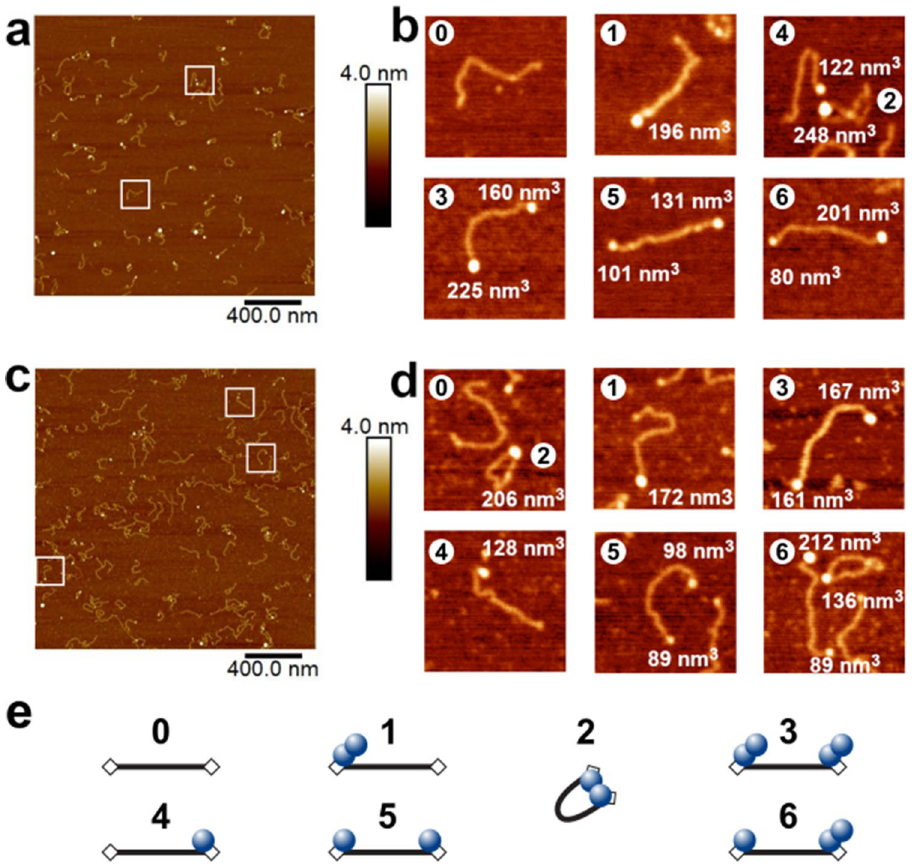
Figure 3. Visualization of AfAgo-induced DNA loops by AFM. Representative AFM images and fourfold enlarged views of WT AfAgo-DNA ( a , b ) and AfAgoΔ-DNA ( c , d ) complexes adsorbed to APS-mica acquired in the air are shown, along with calculated protein volumes. Area of each image in the ( a , c ) is 4 µm 2 , scale bar is 400 nm, the Z range is 4 nm; the Z range of images in ( b , d ) is 3.0 nm. Regions marked by white squares in ( a , c ) indicate several of the observed protein–DNA complexes enlarged in ( b , d ). Based on protein volumes, we assign AfAgo-DNA complexes shown in ( b , d ) to different protein–DNA stoichiometries and arrangements (numbered from 0 to 6) that are schematically depicted in ( e ): “0”—naked DNA; “1”—AfAgo dimer bound to one DNA end; “2”—AfAgo dimer forming a DNA loop; “3”—two AfAgo dimers on different DNA ends; “4”—an AfAgo monomer on one DNA end; “5”—two AfAgo monomers on different DNA ends; “6”—a monomer and a dimer on different DNA